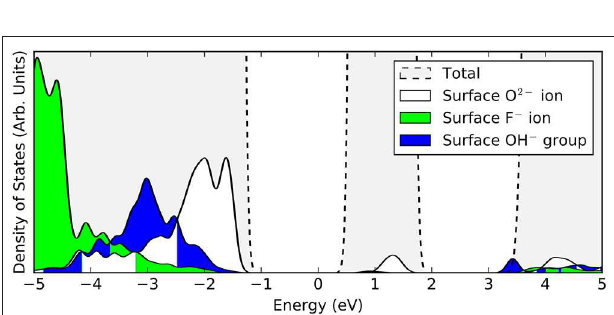
FIGURE 3 | Projected densities of states (PDOS) of a surface oxygen ion (white), surface fluorine ion (green), and a surface hydroxyl group (blue). The total density of states of the stoichiometric slab (gray) is highlighted by the dashed